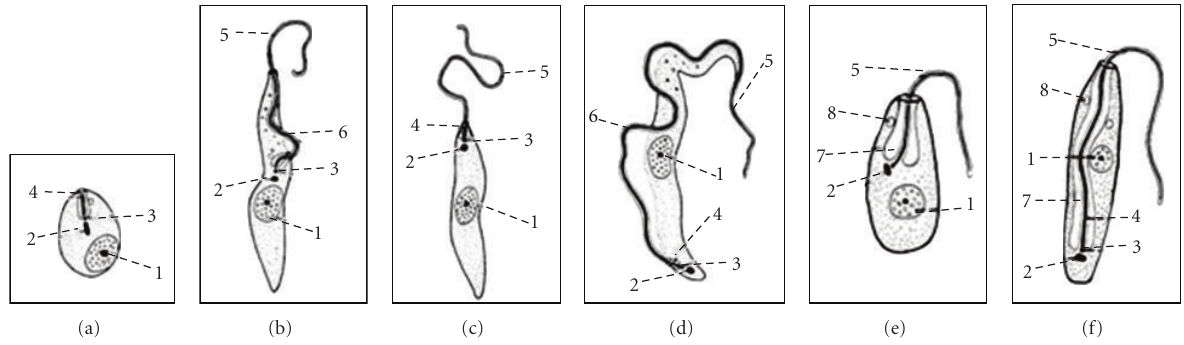
Figure 2: Developmental stages of Trypanosoma cruzi. (a) Amastigote, the nonflagellate intracellular morphologic stage; (b) epimastigote, long spindle-shaped hemoflagellate morphologic form equipped with a free flagellum and an undulating membrane that extends one half of the body length. It is found in the vectors responsible for transmitting the Trypanosoma species; (c) promastigote, characterized by a free anterior flagellum and the kinetoplast at the anterior end of the body; (d) trypomastigote, leaf-like form with an undulating membrane and often a free flagellum; (e) choanomastigote, barleycorn shaped with a collar-like process where the flagella emerges. Intracellular stage inside the invertebrate host; (f) opisthomastigote, no undulating membrane. Found in the invertebrate host only. (1) Nucleus, (2) kinetoplast, (3) basal body, (4) flagellar pocket (5) flagellum, (6) undulating membrane, (7) mitochondrion, and (8) subpellicular